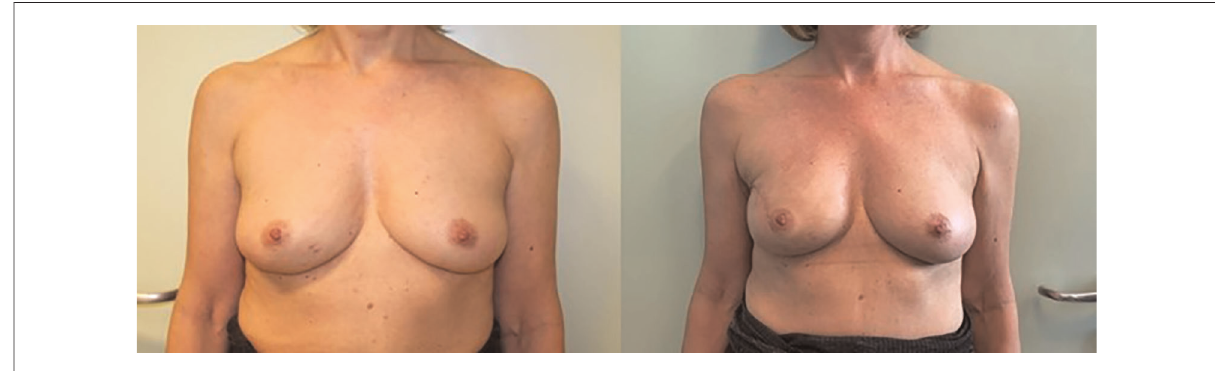
FIGURE 1 IBR with retromuscular implantation, preceded by monolateral nipple-sparing mastectomy. Pre- (left) and post-operative photos (right).